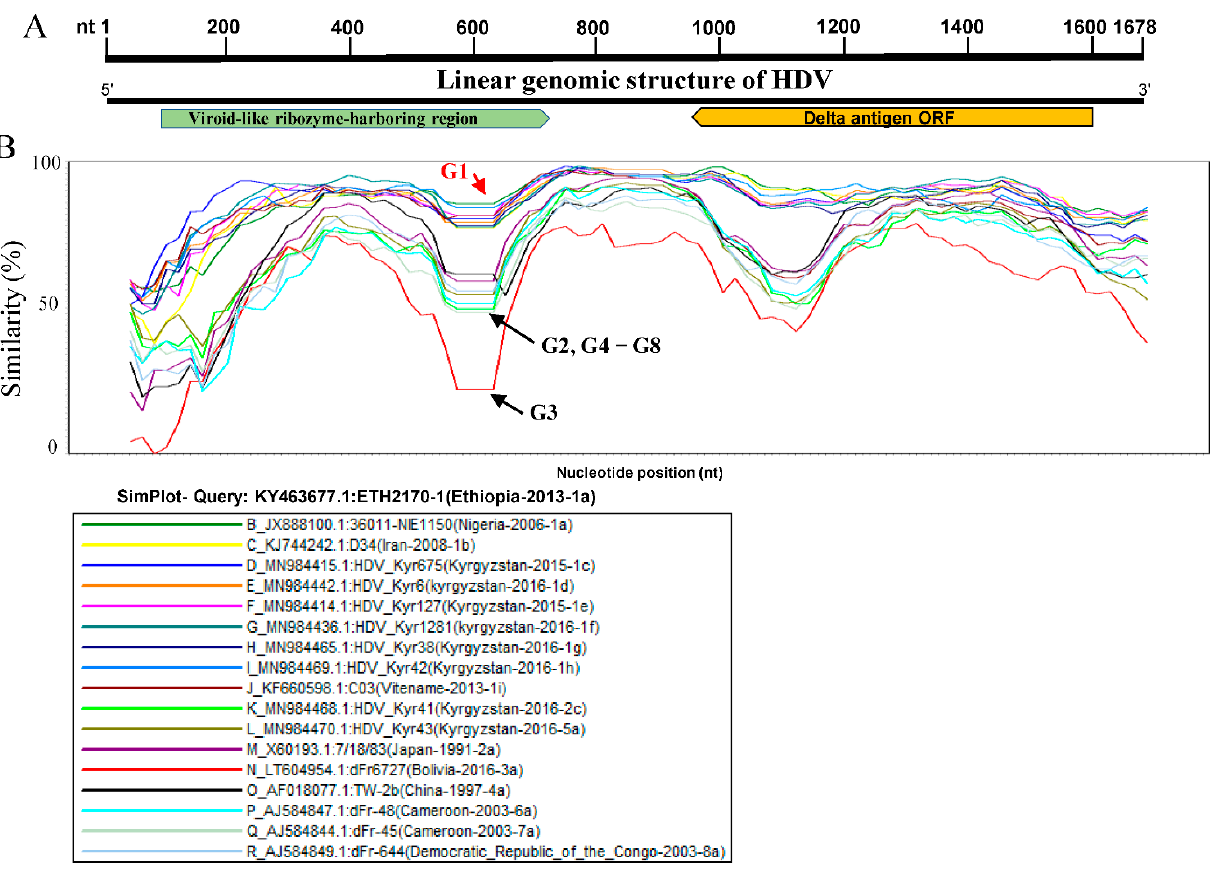
Figure 2. Simplot graph of human HDV genomes. ( A ) Linear Genomic structure of human HDV nucleotide sequences (1678 nt), including the viroid-like ribozyme-harboring region (Rz) and delta antigen ORF. The arrow of delta antigen ORF indicates the direction of translation. ( B ) Comparison of seventeen worldwide representative HDV strains from each sub-genotype in the phylogenetic tree in Figure 1 using similarity analysis. The genomic similarity plot was carried out using SimPlot ver.3.5.1. The X-axes show the nucleotide similarity percentage, and the Y-axes show the nucleotide position. The similarity is presented in percentage (%). The genome of virus ETH2170-1 (GenBank ID: KY463677.1; Ethiopia 2013 1a) was used as SimPlot Query.